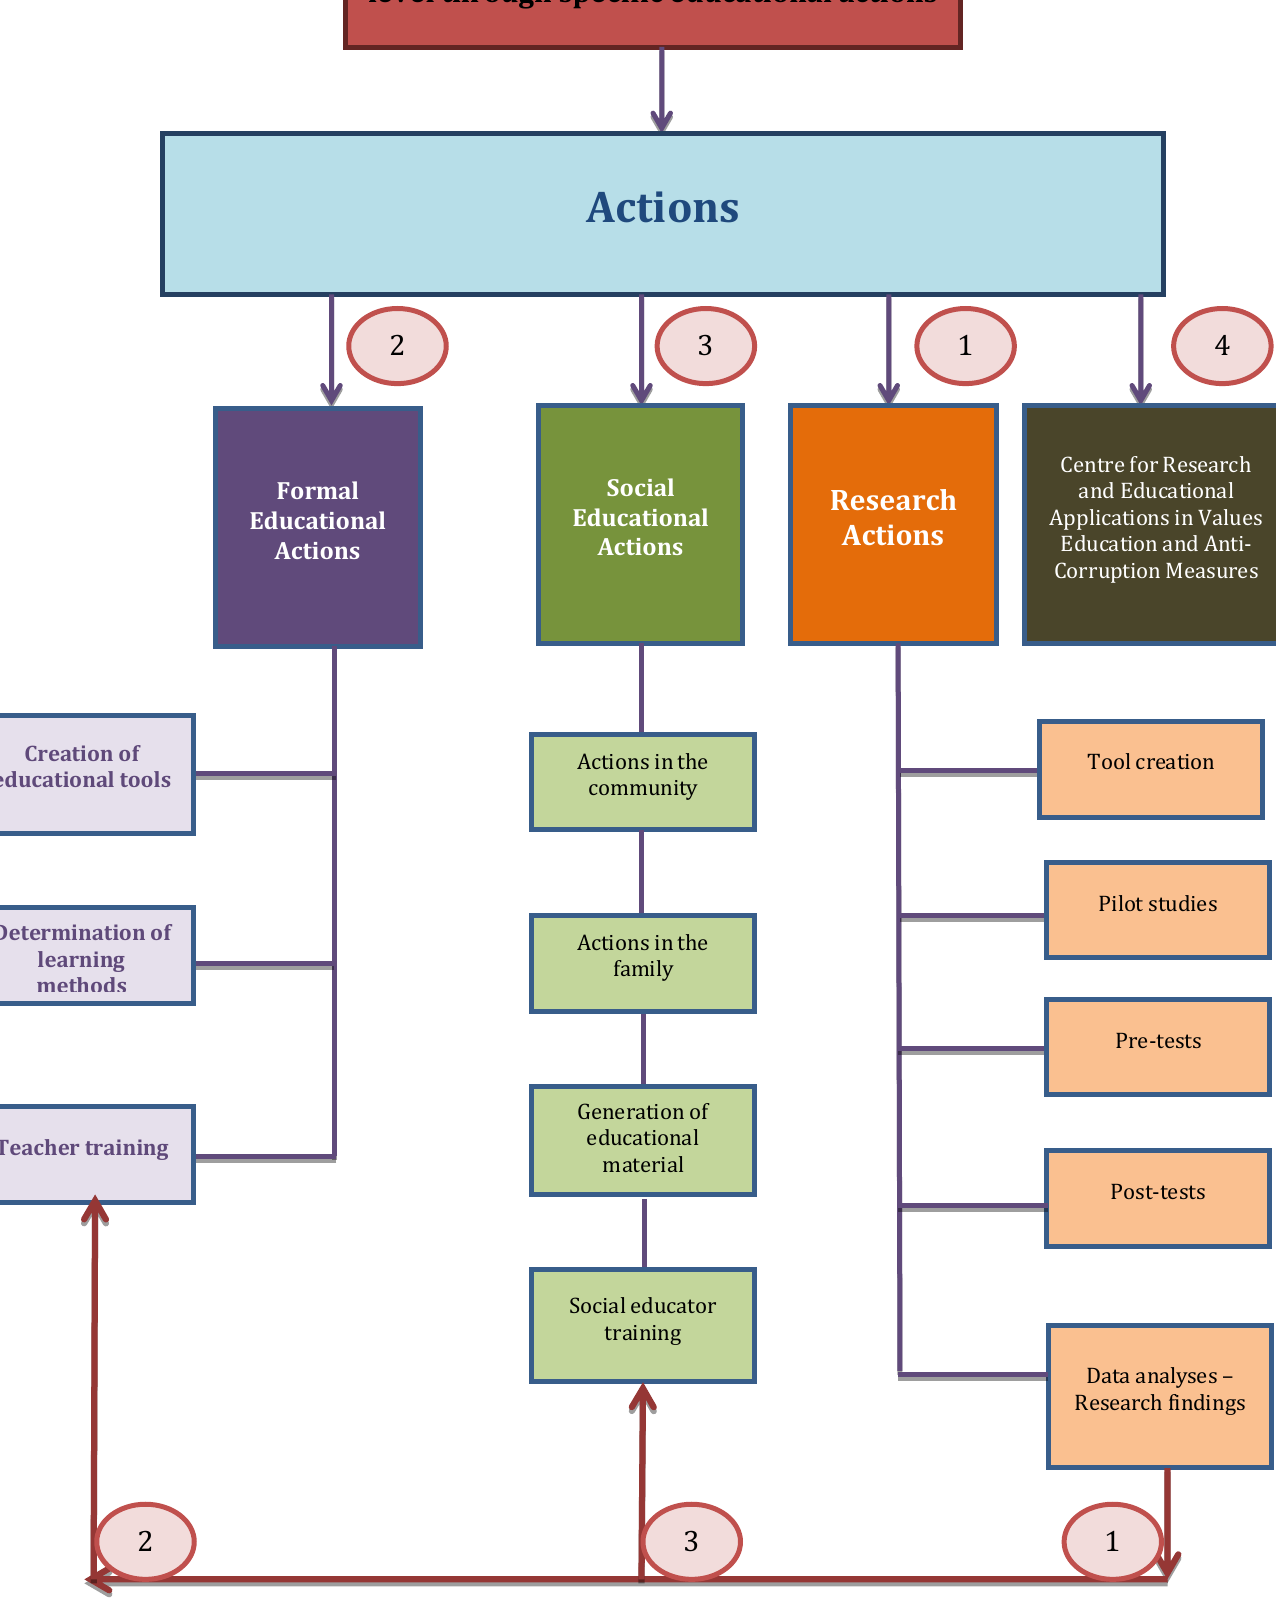
Figure I: Diagrammatic presentation of the ‘Action to fight corruption at the national level through specific educational